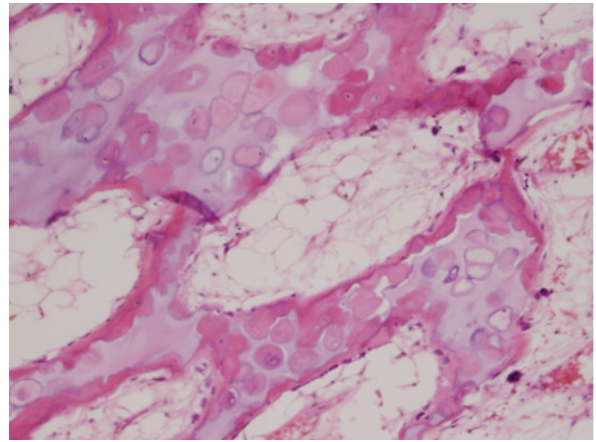
Fig. 8. Gomori’s method impregnated sparse collagen fibres, x200.